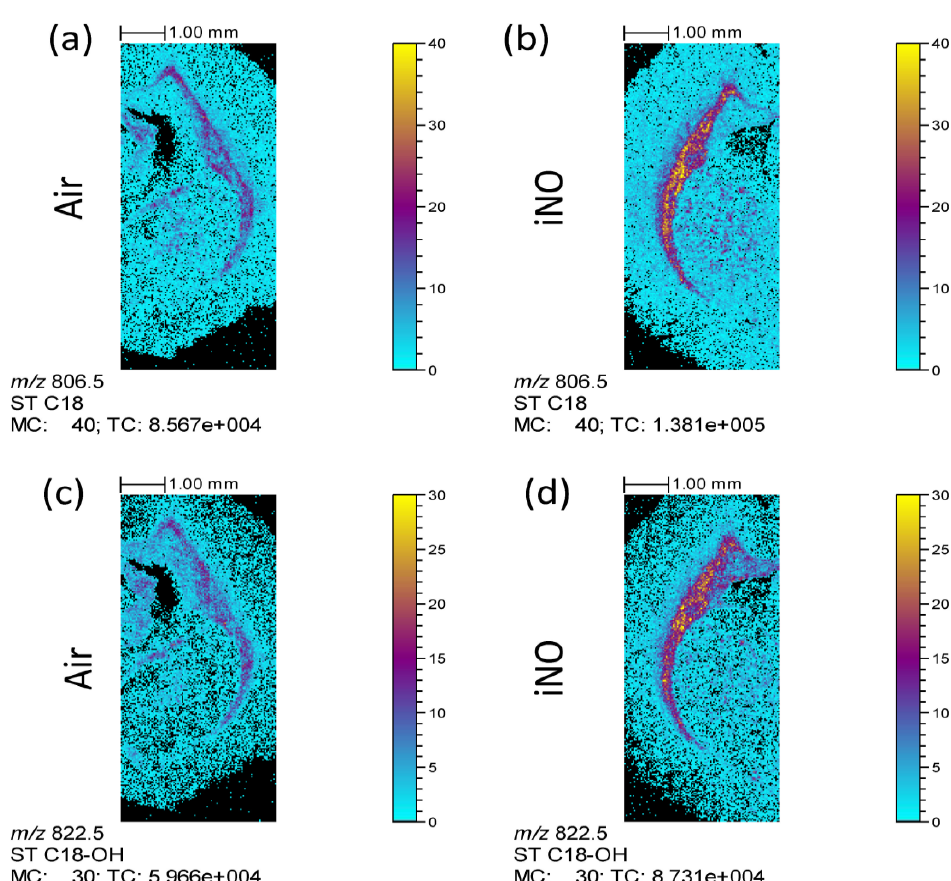
Figure 1. Time-of-flight secondary ion mass spectrometry (TOF-SIMS) negative ion images of coronal rat brain half sections. ( a ) and ( b ): m / z 806.5 (ST C18) ion; ( c ) and ( d ): m / z 822.5 (ST C18-OH) ion. These images have been obtained from different rat half brains at postnatal age P10. ( a ) and ( c ): air-exposed rat; ( b ) and ( d ): iNO-exposed rat. Primary ions: Bi 3+ , 9.5 × 10 9 ions cm − 2 ; areas varying from 7 mm × 9.5 mm to 8 mm × 11 mm. The maximum number of counts (MC) corresponds to the amplitude of the color scale, and the total counts (TC) are the total number of counts recorded for the specified m / z (this is the sum of counts in all the